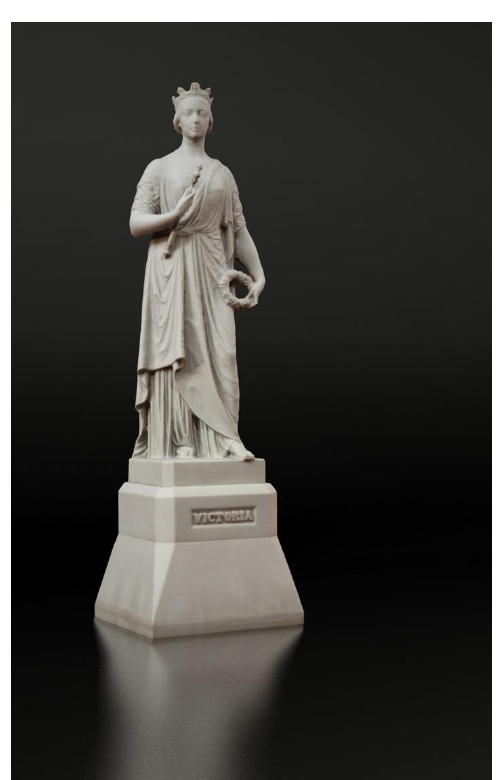
Figure 1. Photogrammetric image network.